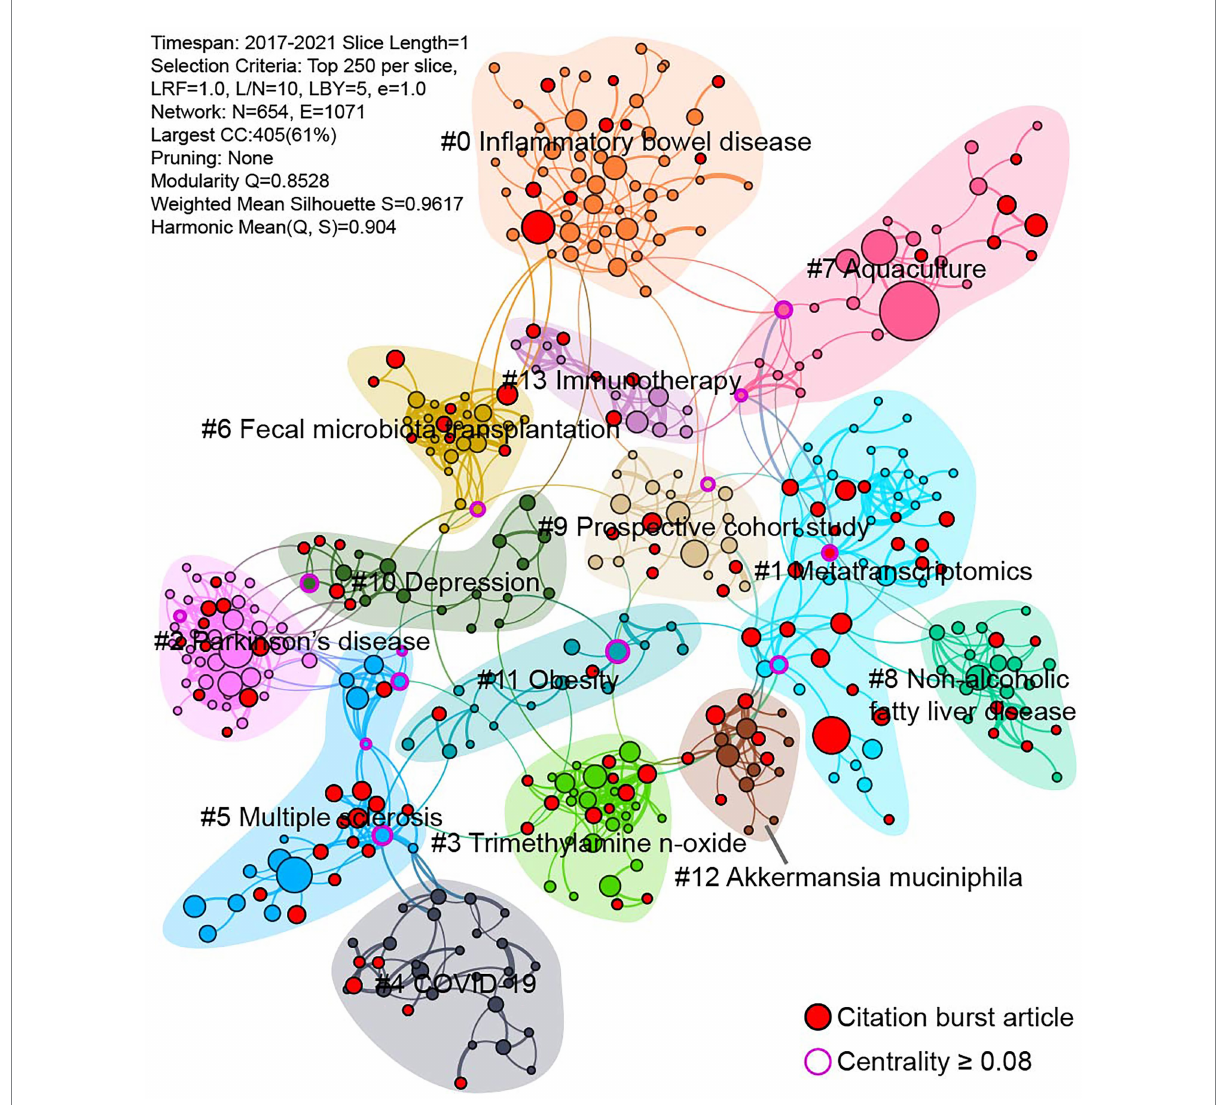
FIGURE 6 Co-cited references network from 2017 to 2021. Each node represents a cited